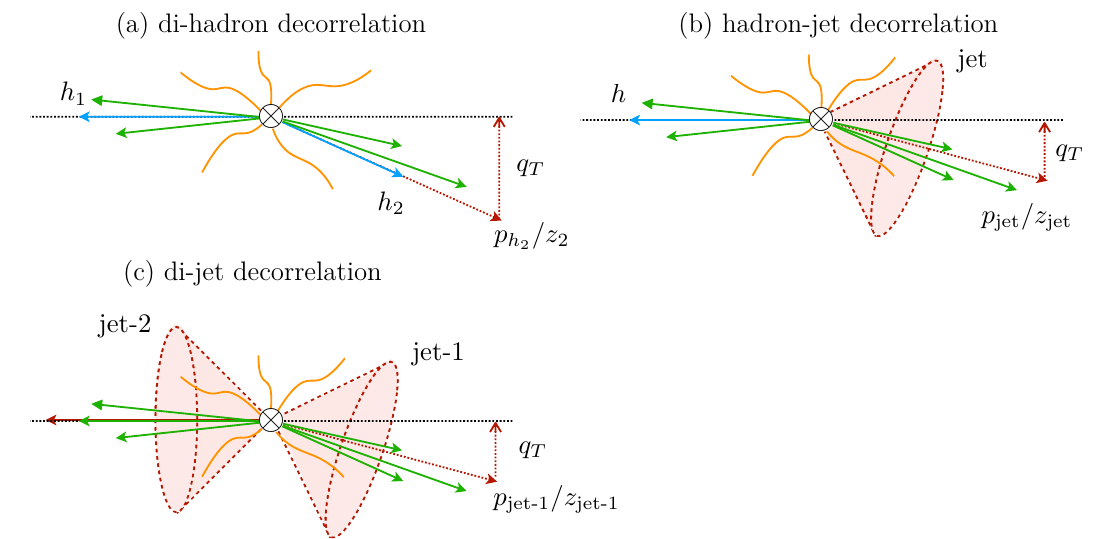
Figure 2 . Three possible transverse momentum de-correlation measurements in e + e (a) Identify two hadrons h (b) Identify a jet and a hadron with momenta p